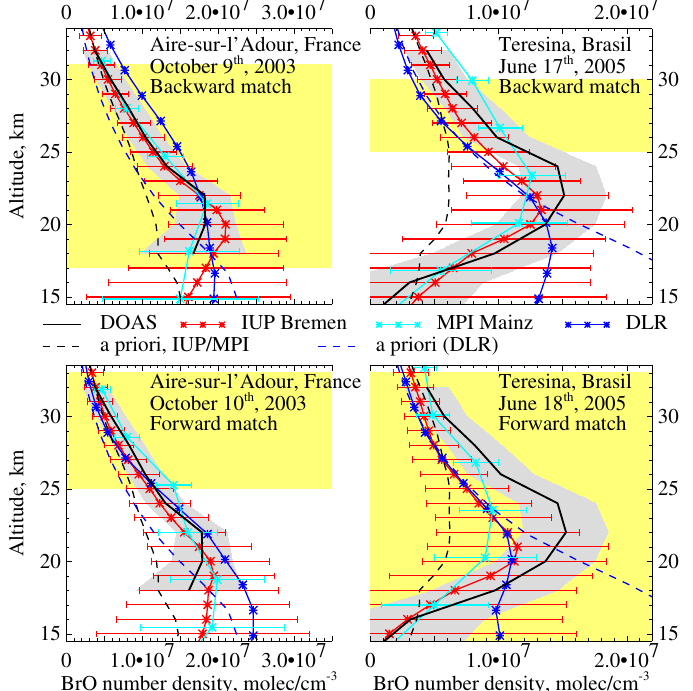
Fig. 23. Comparison of BrO vertical distributions retrieved from SCIAMACHY limb measurements using different retrieval algorithms to coinciding balloon-borne DOAS observations. Left panels: balloon launch in Aire-sur-l’Adour (mid-latitude) on 9 October 2003. Right panels: balloon launch in Teresina (tropics) on 17 June 2005. Gray shadings depict the uncertainties of DOAS results (1- σ ). Yellow areas mark vertical ranges where according to trajectory model calculations both instruments probe the same air